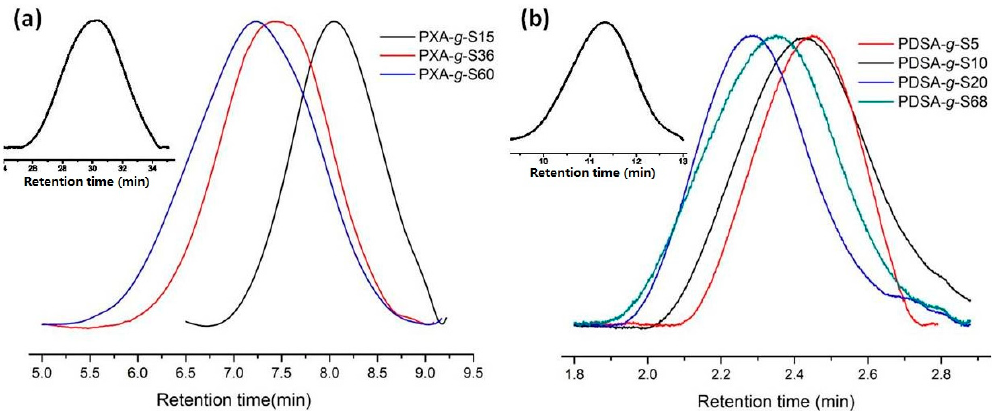
Figure 2 . Size exclusion chromatography (SEC) traces of ( a ) stearoyl grafed poly(xylitol adipate) in THF; ( b ) SEC traces of stearoyl grafted poly( D -sorbitol adipate) in THF. The insets show the SEC traces of the polymer backbones PXA and PDSA, respectively, in DMF.